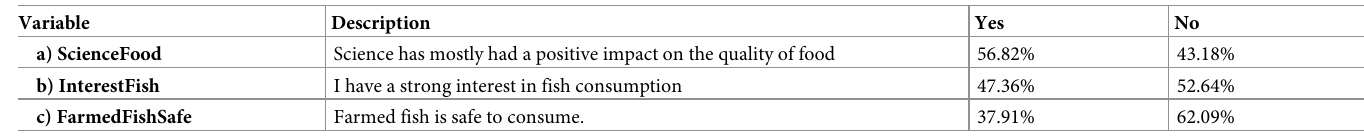
Table 2. Attitudes to science and interest in fish consumption among study participants. Variable